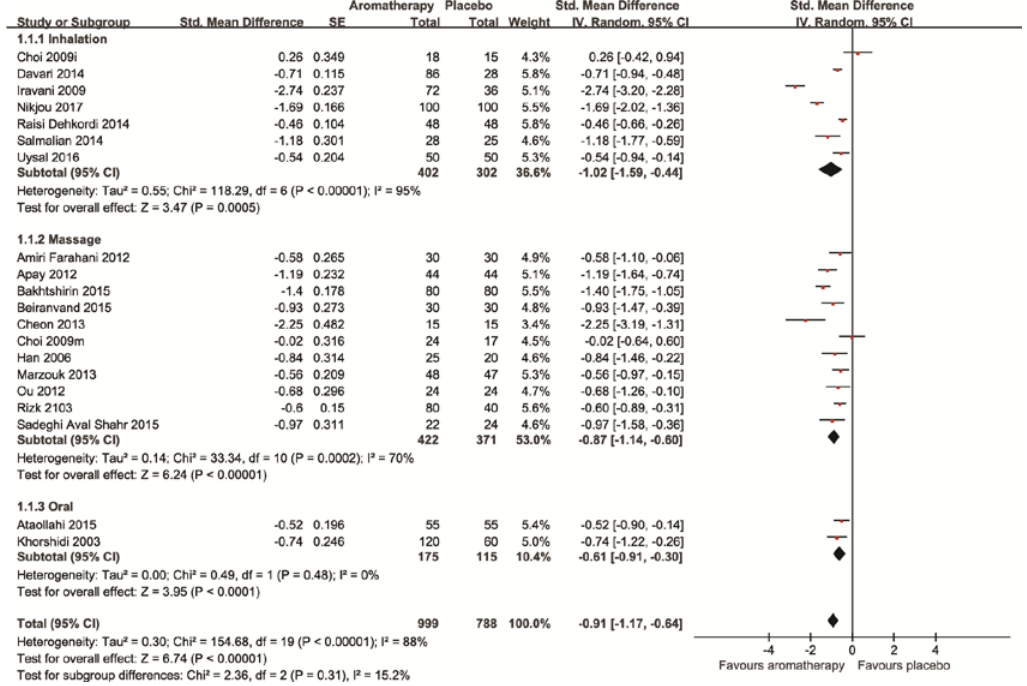
Figure 3. Forest plot of effects of aromatherapies on pain of primary dysmenorrhea.